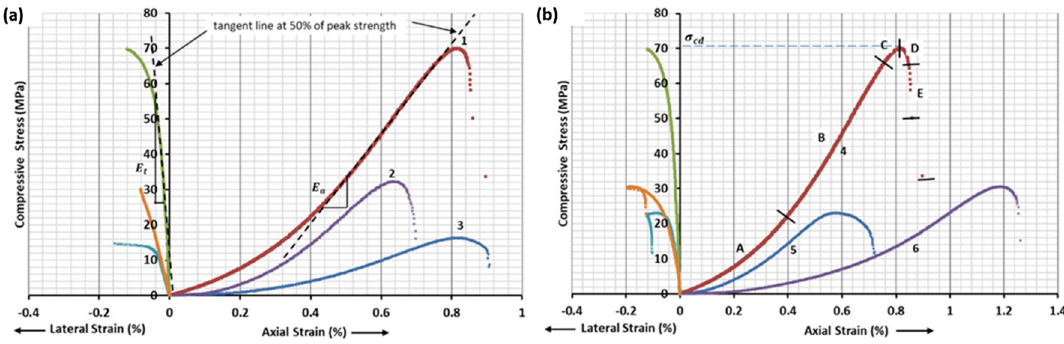
Figure 7. Stress vs. strain curve developed after UCS